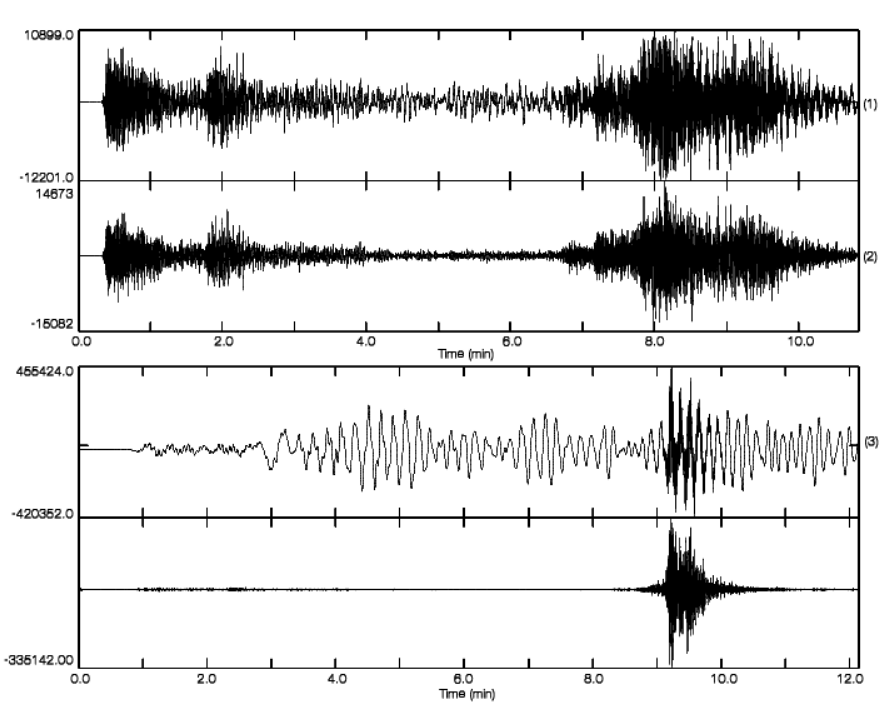
Fig. 4. Seismograms of the vertical components of ROB (upper) and GENL (lower) before and after applying the bandpass filter 0.5-20 Hz.